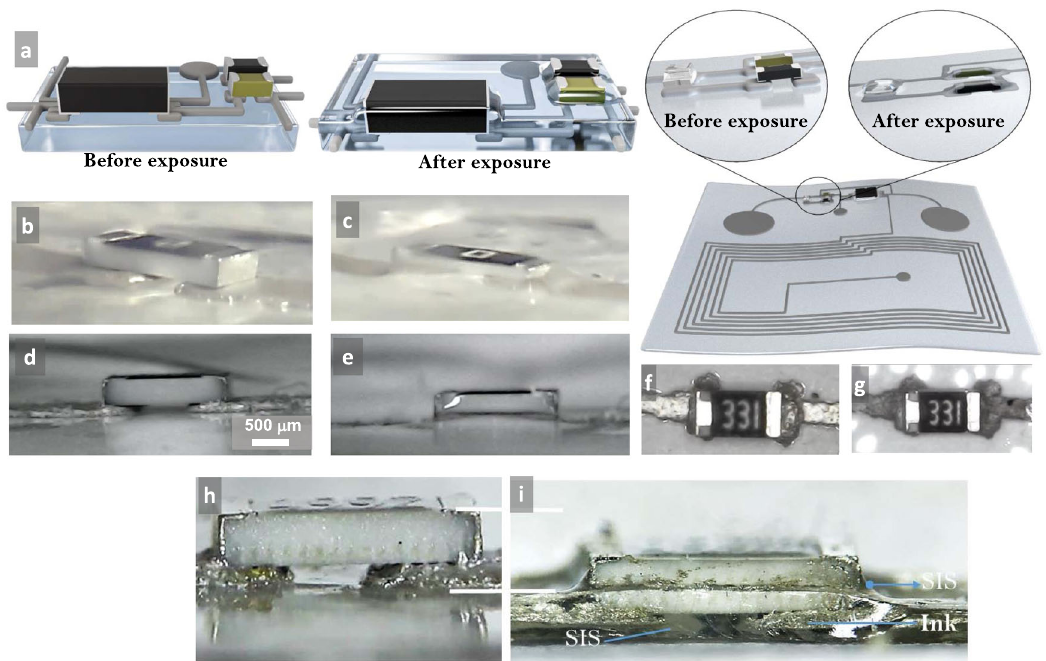
Fig. 4 Details of the self-soldering process. a A schematic presentation of the microchip integration into the soft-matter circuit before and after exposure. Snapshot of a resistor component before ( b ) and after vapor exposure ( c ). Note the penetration of the component and the ink into the substrate. Side view of a resistor chip before ( d ) and after ( e ) vapor exposure. The light re fl ection of the chip after exposure shows the SIS that climbed the walls of the chip due to capillary action. Top view of the resistor chip before ( f ) and after ( g ) vapor exposure. The color difference of the ink demonstrates encapsulation. Magni fi ed side view of the resistor chip before ( h ) and after ( i ) vapor exposure. All of the ink and approximately half of the resistors are inside the substrate. Note also the SIS below the resistor and on the